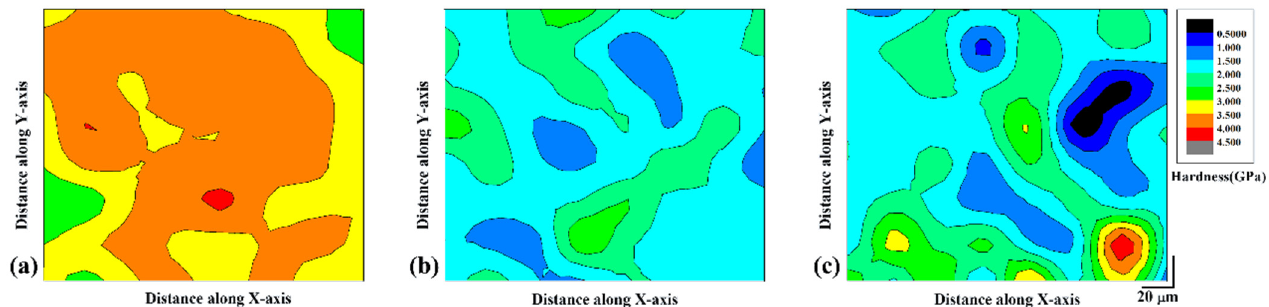
Figure 7. Hardness contour maps for the Al-20Si-5Fe-3Cu-1Mg SLM sample plotted from the nano-indentation data: ( a ) as-prepared SLM, ( b ) SLM + thermal treatment at 673 K for 6 h, and ( c ) SLM with substrate plate heating at 673 K.